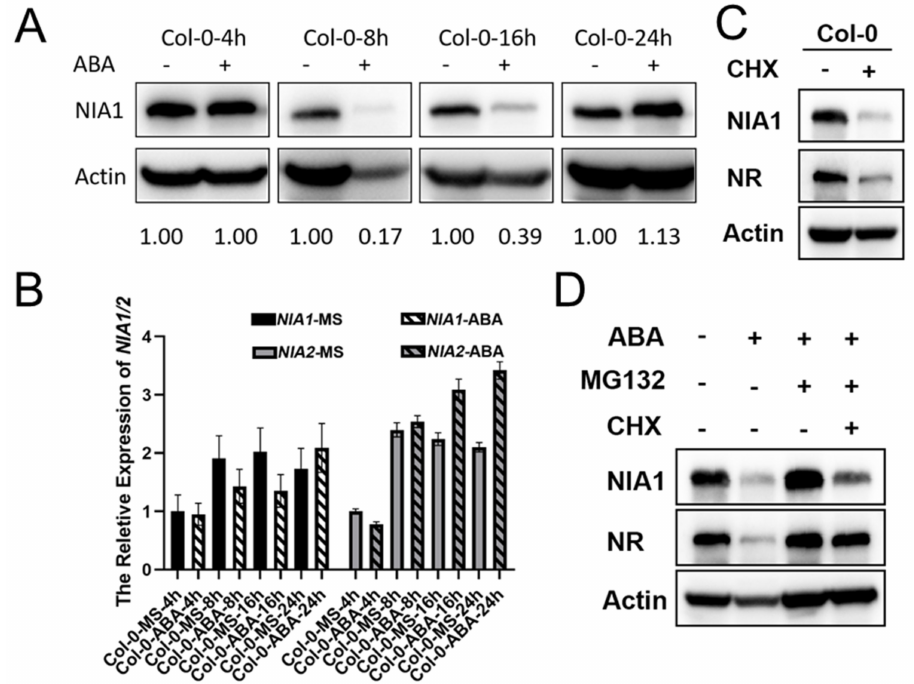
Figure 2. NR proteins are degraded via a 26S proteasome under short-term ABA treatment. ( A ) West- ern blot of the proteins extracted from seedlings under indicated treatments by the NIA1 antibody and NR antibody. The quantification of relative levels of NIA1 proteins are shown below; ( B ) Western blot of the proteins extracted from seedlings under the indicated treatments by the NIA1 antibody and NR antibody. The quantification of relative levels of NIA1 proteins are shown below; ( C ) gene expression analysis of NIA1 or NIA2 transcripts in the indicated background with or without ABA treatment. Three biological repeats; ( D ) Western blot of the proteins extracted from seedlings under the indicated treatments by the NIA1 antibody and NR antibody. The quantification of the relative levels of NIA1 proteins are shown